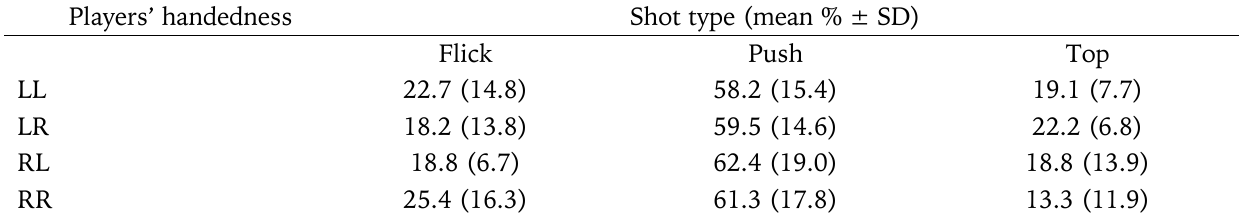
Type of shot distribution of S2 in relation to serving and receiving player’s handednes.